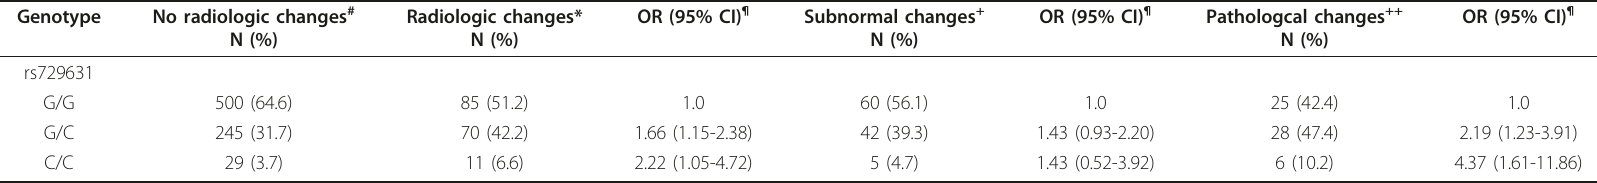
Table 4 Distribution of SERPINE2 genotypes according to the existence and severity of panlobular emphysematous